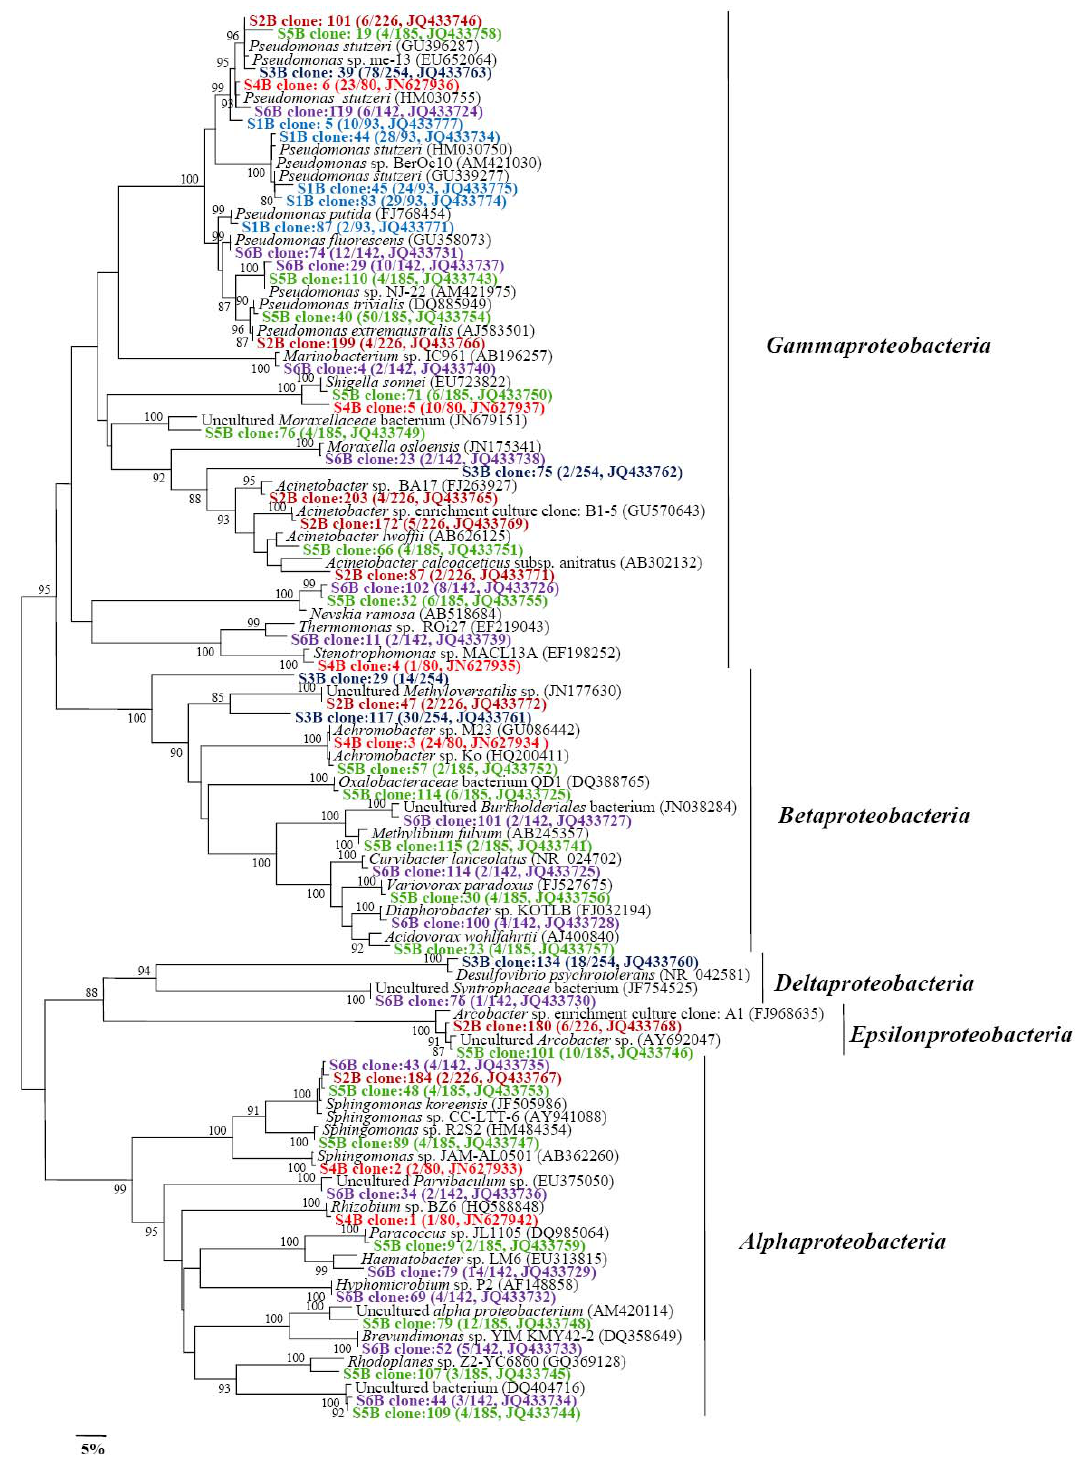
Fig. 1. Phylogenetic tree of the Alphaproteobacteria , Betaproteobacteria , Gammaproteobacteria , Deltaproteobacteria and Epsilonpro- teobacteria 16S rRNA gene phylotypes retrieved from six different petroleum reservoirs (shown in bold) and closely related sequences from GenBank database. Alignments to related sequences (shown with accession number) were performed with MEGA 5 software. The topology of the tree was obtained with the neighbor-joining method. Bootstrap values ( n =1000 replicates) of ≥ 75% are reported. Scale bar represents nucleotide changes per site. Sampling locations are as named in Table